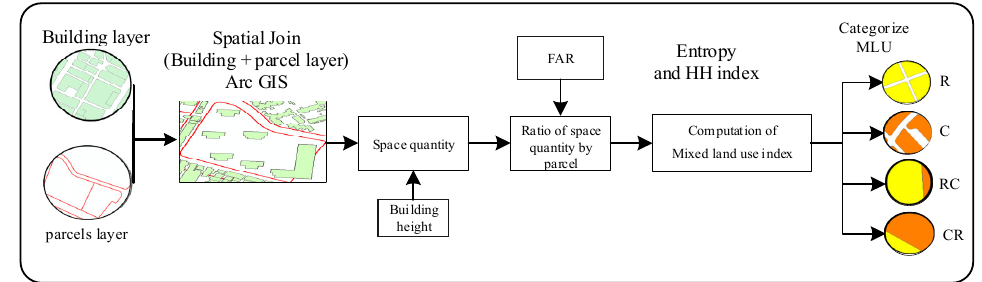
Figure 4. The process of data preparation.